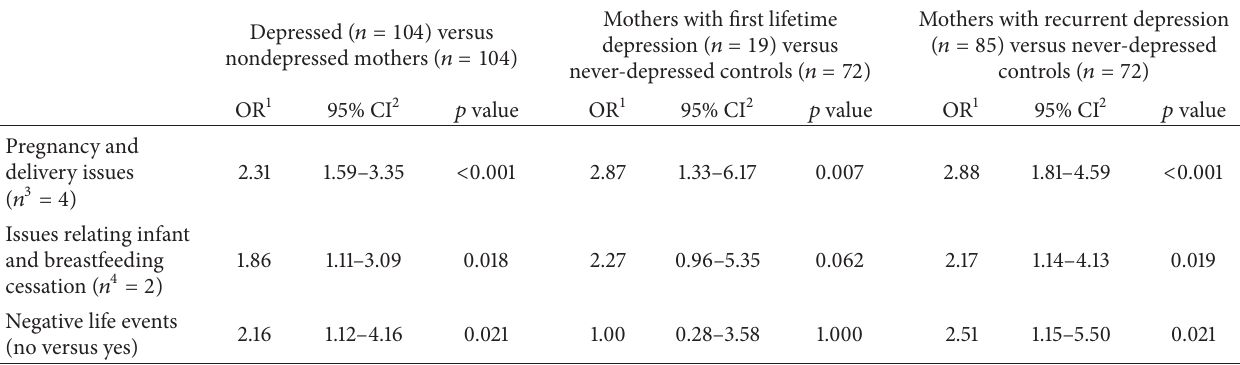
Table 3: Age-adjusted risk for having postpartum depression according to multivariate logistic regressions in relation to the course of